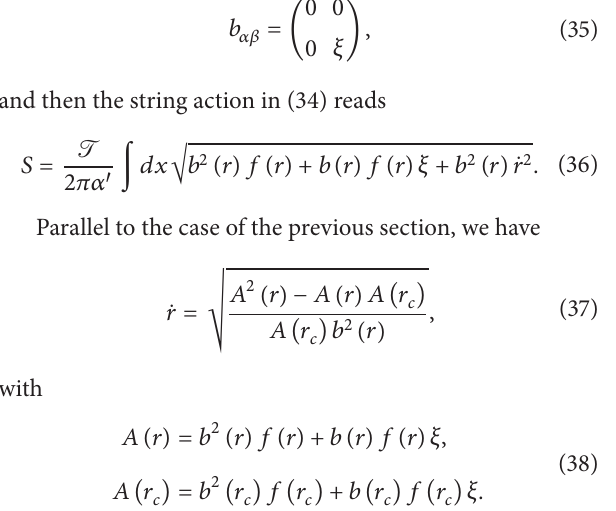
Figure3:Plotsof 𝑉 versus 𝐿 withdifferent 𝜉 .Here 𝑧 = 1.7 and 𝜃 = 1 . From top to bottom 𝜉 = 3.0, 1.5, 0.1 ,